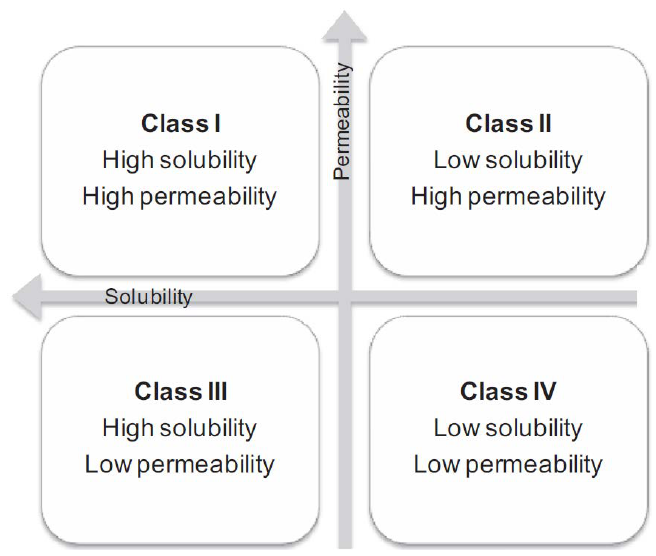
Figure 1. Schematic representation of Biopharmaceutics Classification System (BCS) of Drugs [Reprinted from [1] with permission from Elsevier].